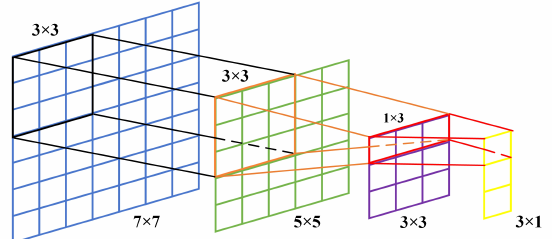
Figure 4. Convolution kernel decomposition.